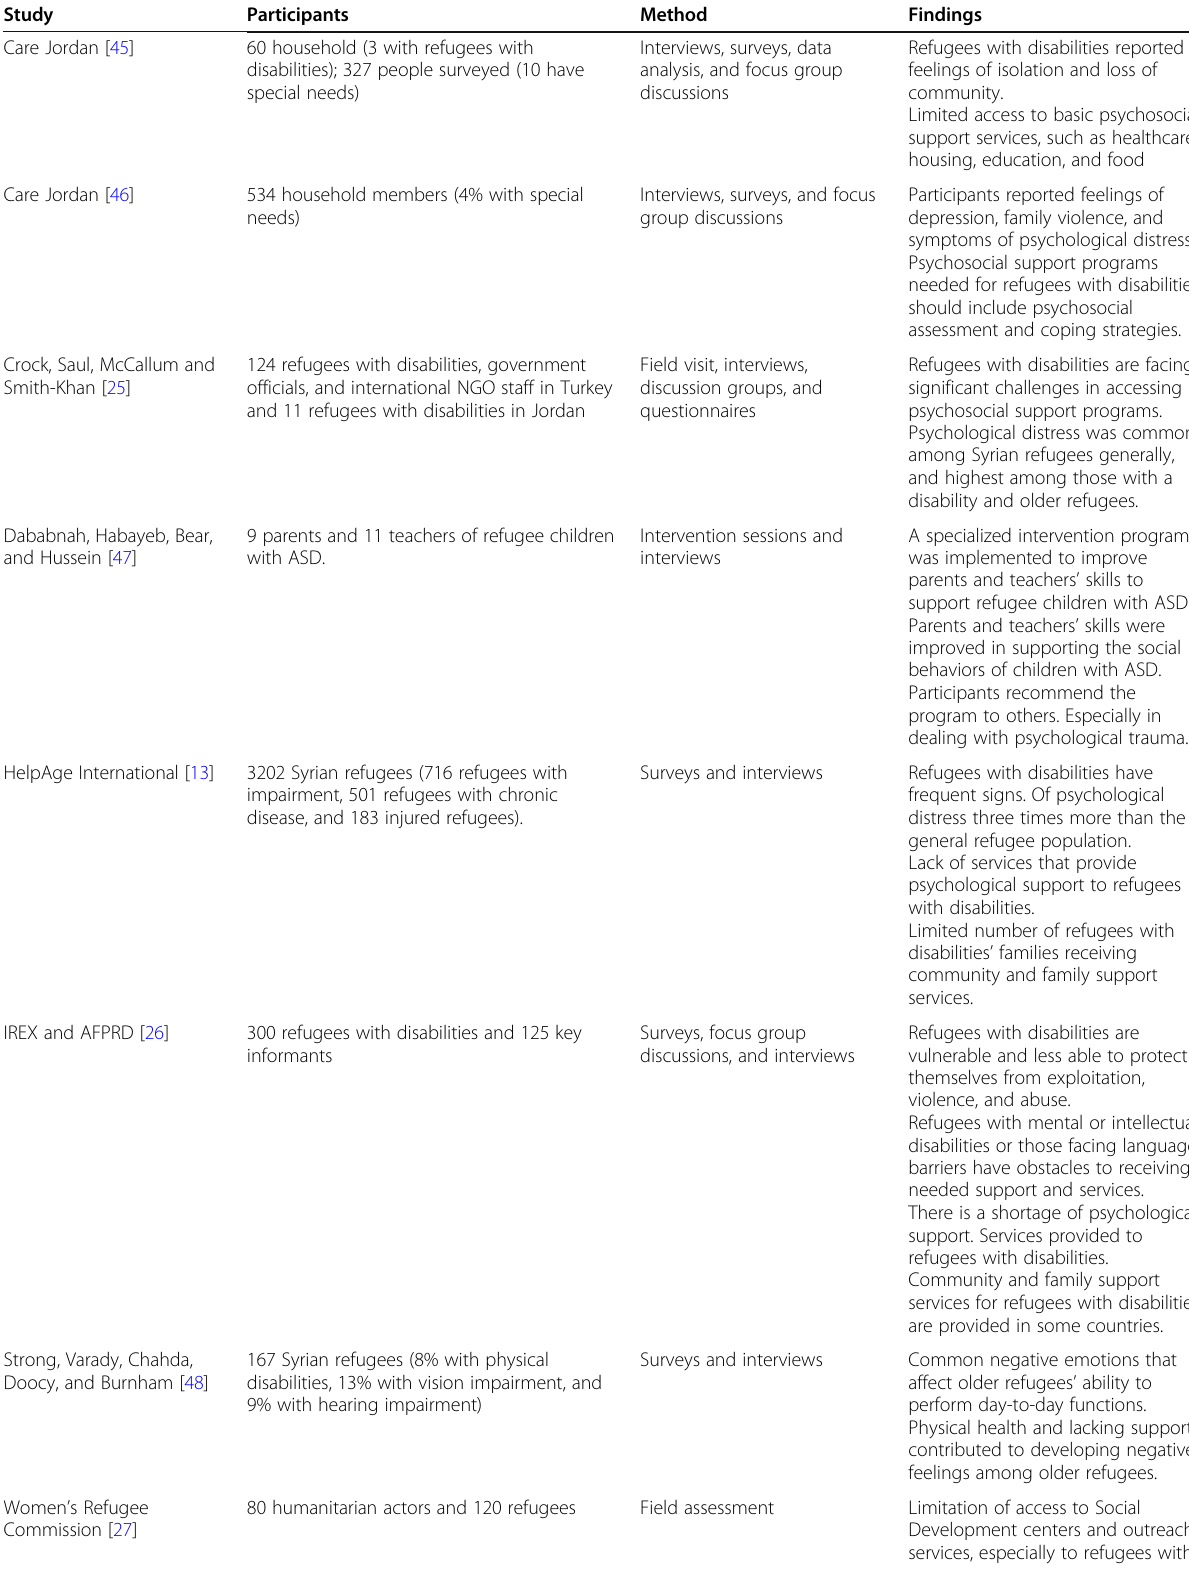
Table 1 Identified studies ’